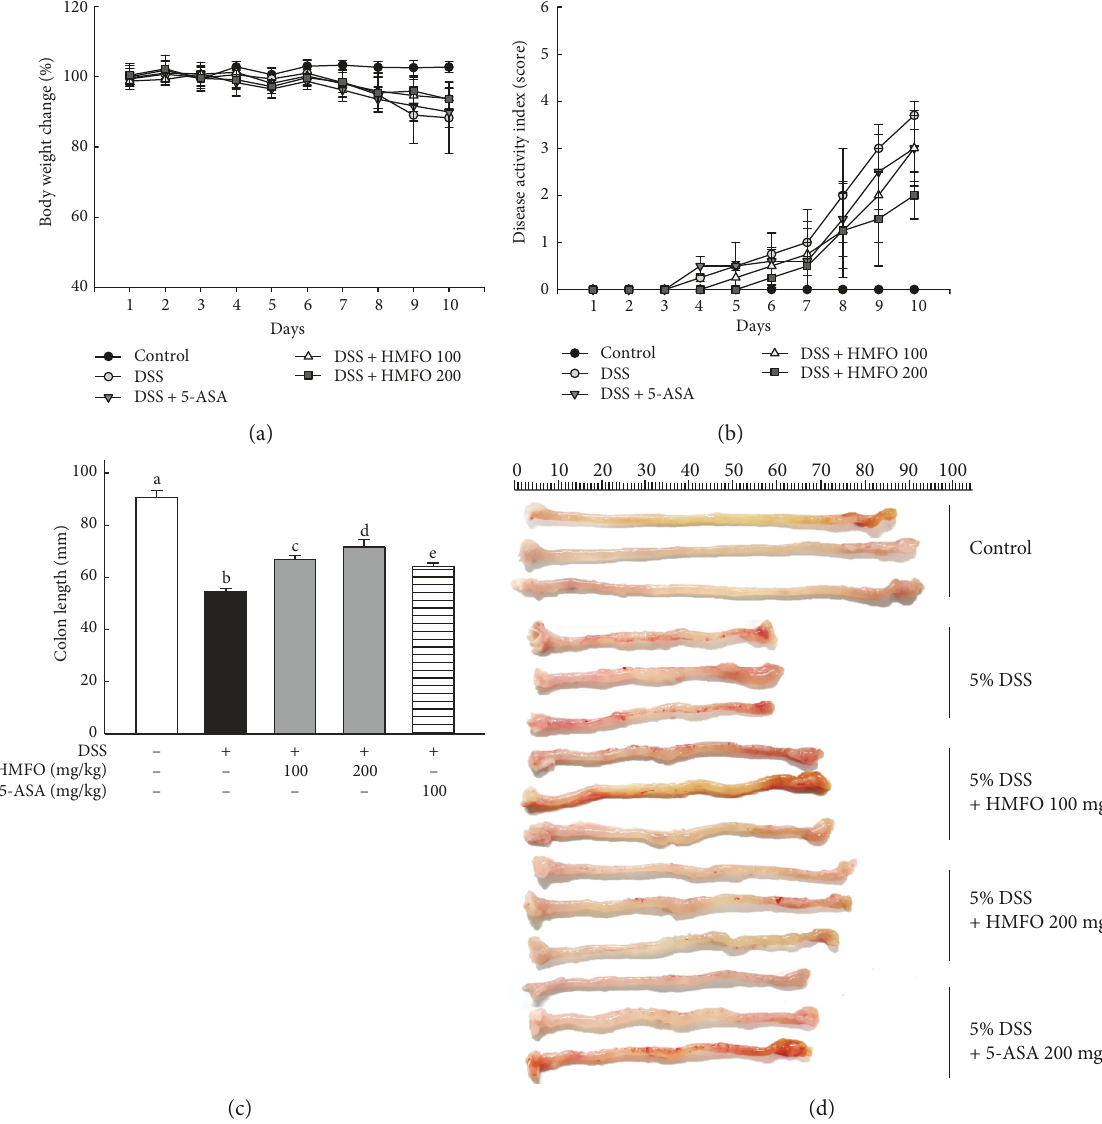
Figure 1: E ff ects of HMFO on clinical signs and colon lengths in mice with DSS-induced colitis. (a) Changes in body weight and (b) disease activity index scores in the control, DSS, DSS+ HMFO 100 (100mg/kg), DSS + HMFO 200 (200mg/kg), and DSS+ 5-ASA 100 (100mg/kg) groups were evaluated daily. (c) The length of each colon was measured and averaged. Values with di ff erent letters are signi fi cantly di ff erent ( p < 0 05 ). (d) Colons were removed from DSS-treated mice on day 10, opened longitudinally, washed with PBS, and photographed. 5-ASA, 5-aminosalicylic acid (100mg/kg); DSS, dextran sulfate sodium; HMFO, polysaccharides of Cynanchum wilfordii (100 or